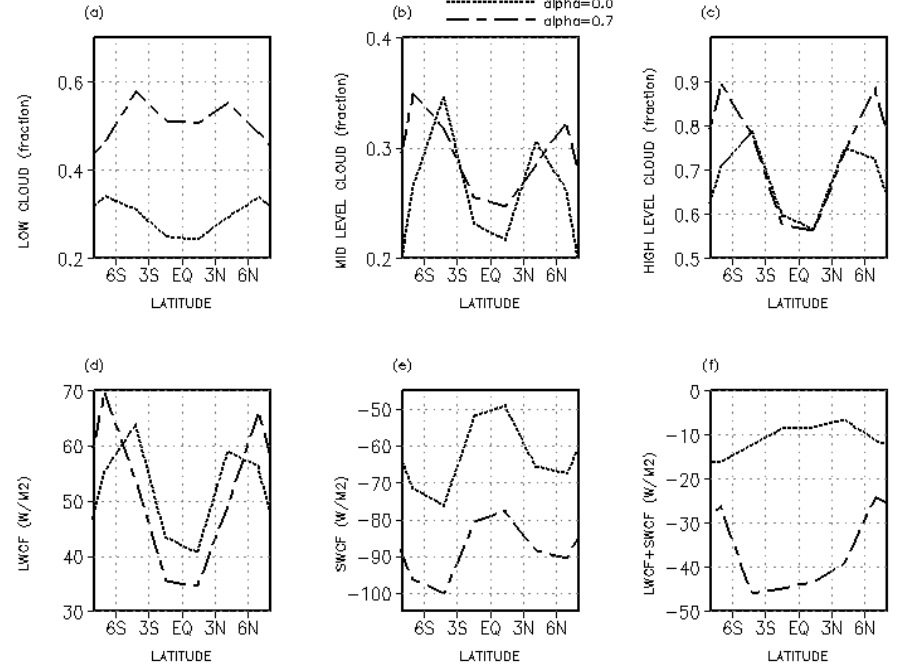
Fig. 12. Zonally averaged time mean quantities for α =0 and α =0.7. (a) low cloud (fraction), (b) mid level cloud (fraction), (c) high level cloud (fraction), (d) longwave cloud radiative forcing (W/m 2 ), (e) shortwave cloud radiative forcing (W/m 2 ), (f) net (long wave +short wave) cloud radiative forcing (W/m 2